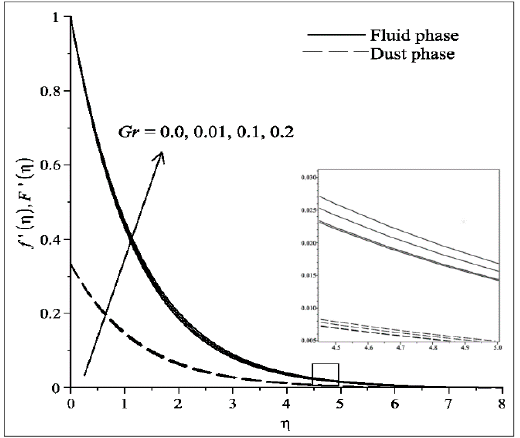
Gr Gr Gr Figure 10. Profile on velocity for various Gr